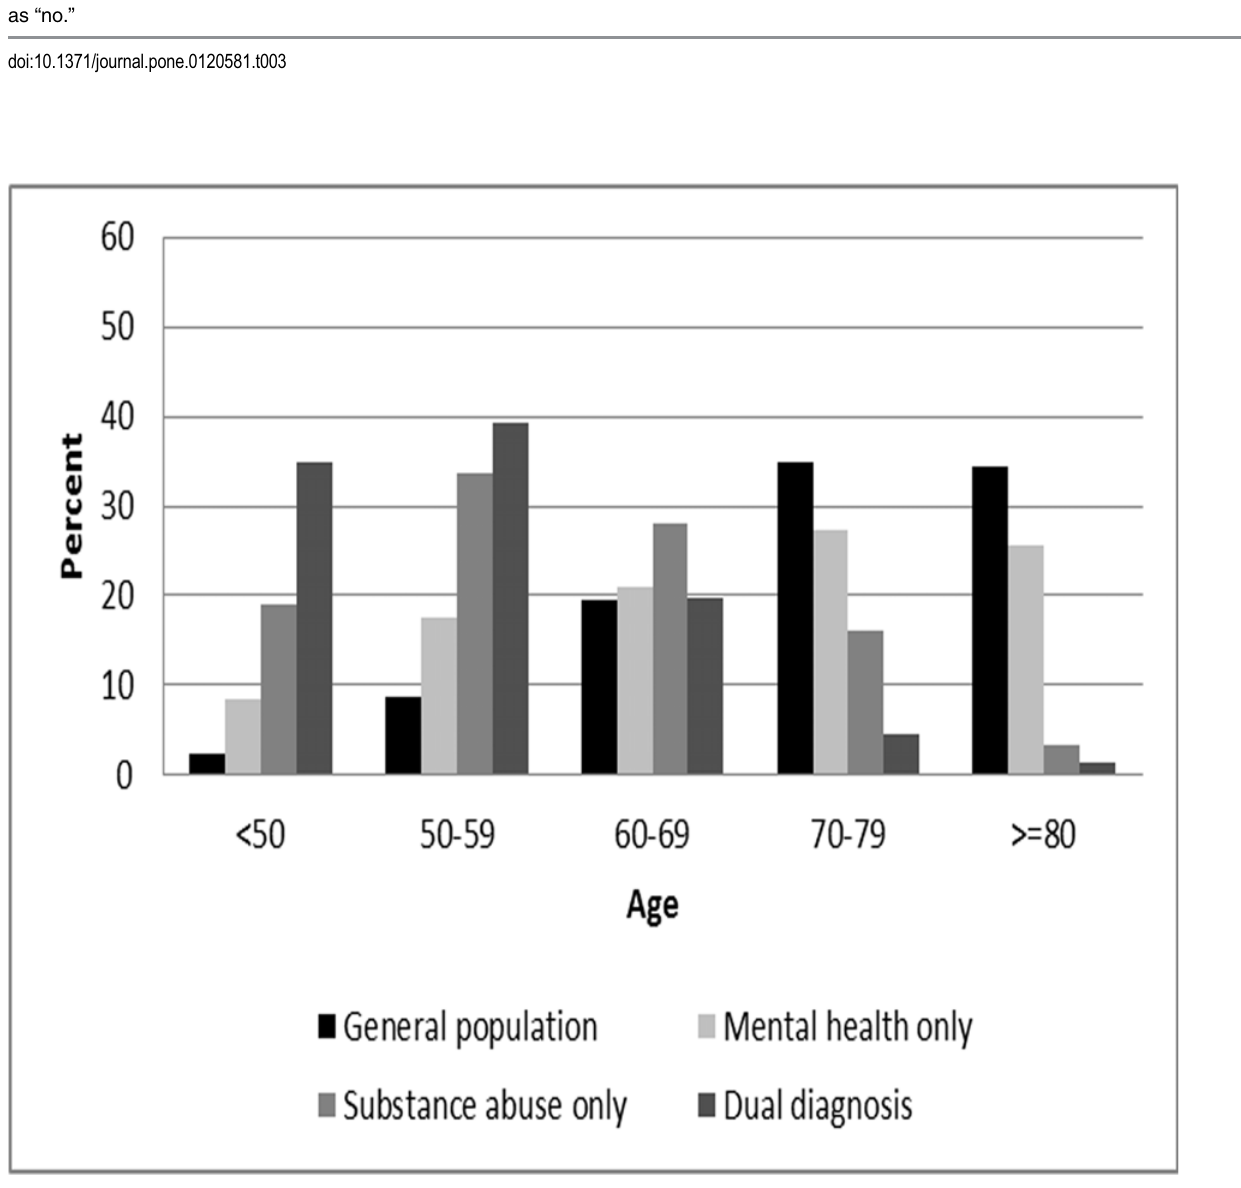
* Includes 46,209 cases where the role of tobacco in the death was coded as “ de fi nitely ” or “ probably, ” and 102,552 where the role of tobacco was coded